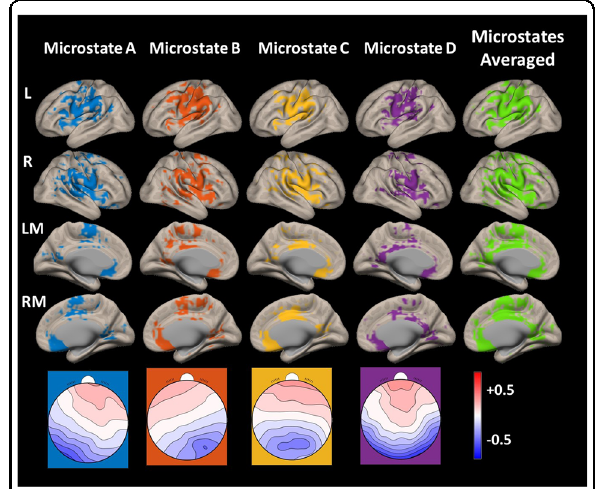
Fig. 2 EEG microstates. The topographic maps of the EEG microstates an exemplary subject (bottom row) and correspondingbrain networks masks of each microstate identi fi ed using topographic electrophysiological state source-imaging (TESS) method. The coloured regions in the 3D brain networks masks depict the regions of neuronal generators of EEG microstates. The last column images show the average image of the microstates brain network masks. The left (L), right (R), left medial (LM) and right medial (RM) views are shown in each row of the 3D source-localised images.